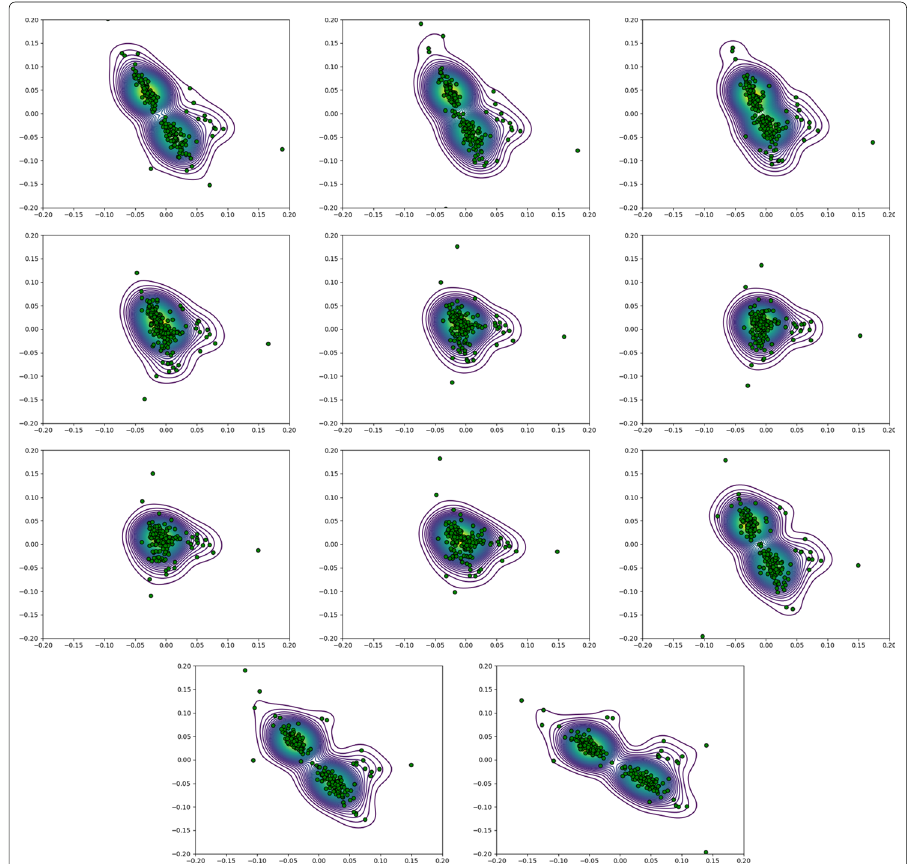
Fig. 3 Synthetic graph interpolation. The interpolation’s frames are presented from left to right, and top to bottom. At the top left, the first frame is the third data snapshot, the sixth frame is the fourth data snapshot, and the eleventh frame is the fifth data snapshot; the interpolated frames are taken at evenly spaced time intervals between the data snapshots. The interpolated frames show a clear progression of community merging and splitting as well as some outliers that do not seem strongly attached to any